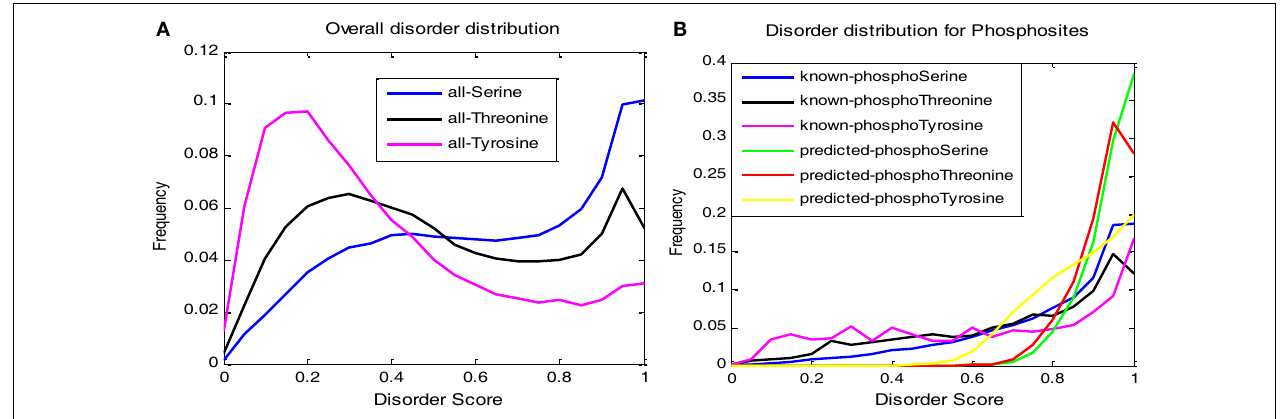
FIGURE 4 | Distribution of disorder scores: (A) Distribution for all S,T, andY sites; (B) distribution of phosphosites for both known and predicted cases.